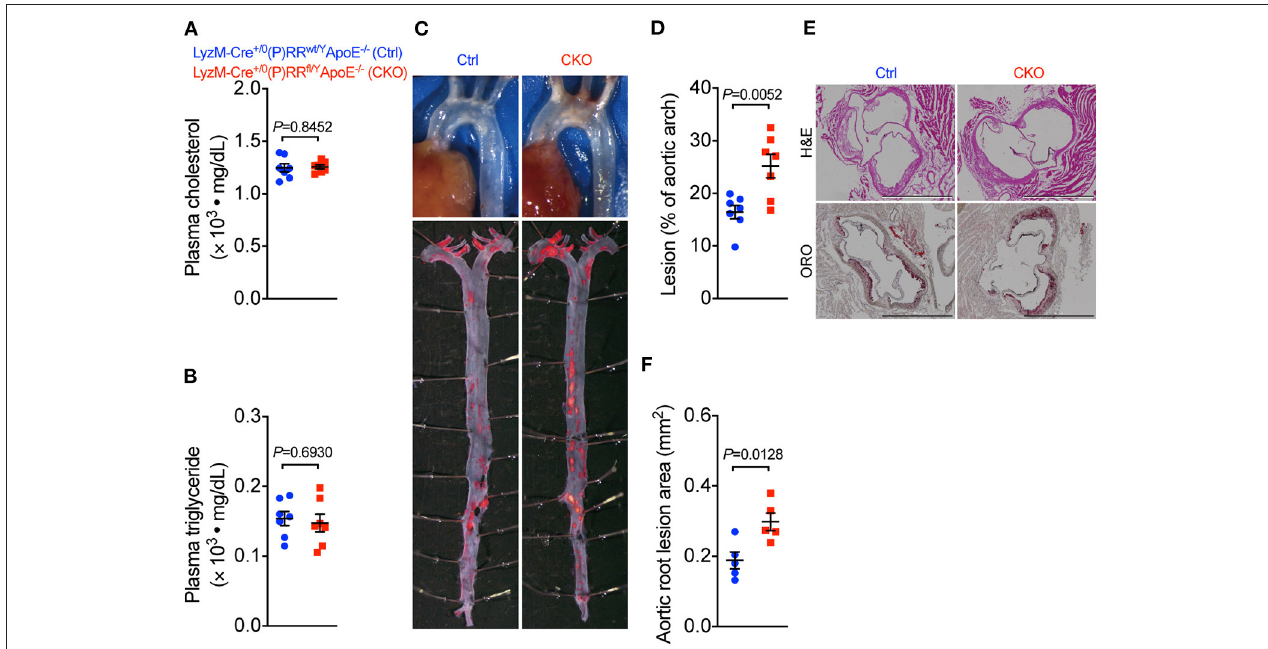
FIGURE 4 | Deleting (P)RR in macrophages accelerated atherosclerosis in ApoE − / − mice. Eight-week-old Lyz2-Cre + / 0 (P)RR wt / Y ApoE − / − mice (Ctrl) and Lyz2-Cre + / 0 (P)RR fl / Y ApoE − / − mice (CKO) were fed a WTD for 12 weeks. N = 7 per group. Plasma cholesterol and triglycerides concentrations (A,B) . Representative images showing aortic arch and ORO-stained whole aorta (C) . Quantification of lesion area in whole aorta (D) and aortic arch region (E) . Representative images showing